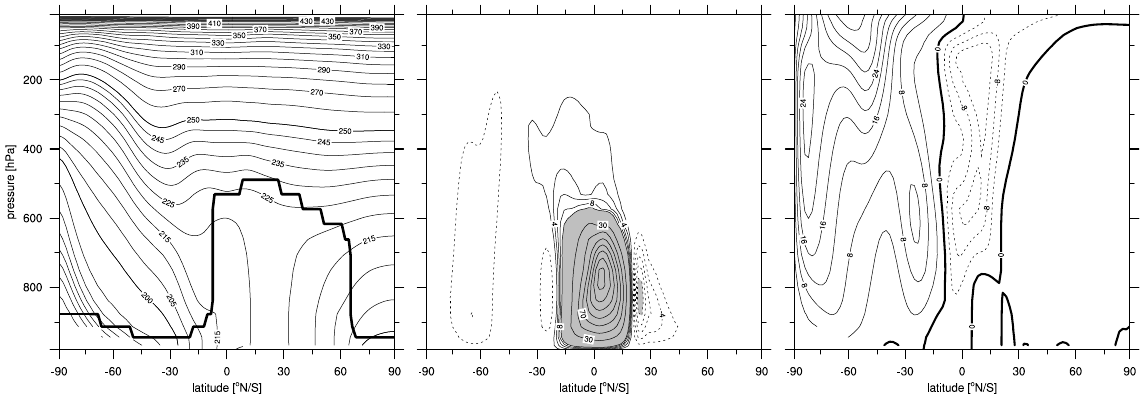
Fig. 2. Zonal-mean circulation of the Snowball Earth atmosphere for perpetual off-equatorial insolation. Left panel: potential temperature in K. Contour interval is 5K between 200, 250 and 10K otherwise. The black solid line depicts the tropopause (see text). Middle panel: mass stream function in units of 10 9 kgs − 1 . Solid (dashed) contour lines represent counterclockwise (clockwise) circulation. Contour interval is 2 between − 10 and 10, and 20 otherwise (gray shading). Left panel: zonal wind in ms − 1 . Contour interval is 4, with a thick zero contour line.